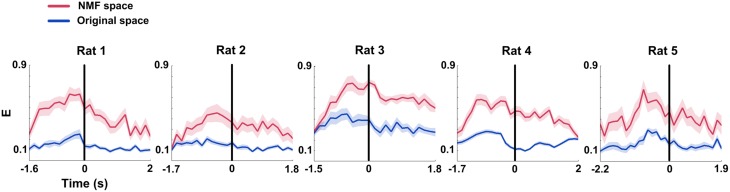
Global efficiency (E) features of mPFC spike network during correct WM trials in original and NMF spaces. Red lines: NMF space. Blue lines: original space (nRat 1 = 20 trials, nRat 2 = 13 trials, nRat 3 = 18 trials, nRat 4 = 27 trials, nRat 5 = 18 trials). E increased to peaks prior to the maze choice point in both of the two spaces. The difference was that the mean E in NMF space stayed above the values in original space. Abscissa: time course that the rat ran from the start point to the reward site. Shaded area indicates the SEM.